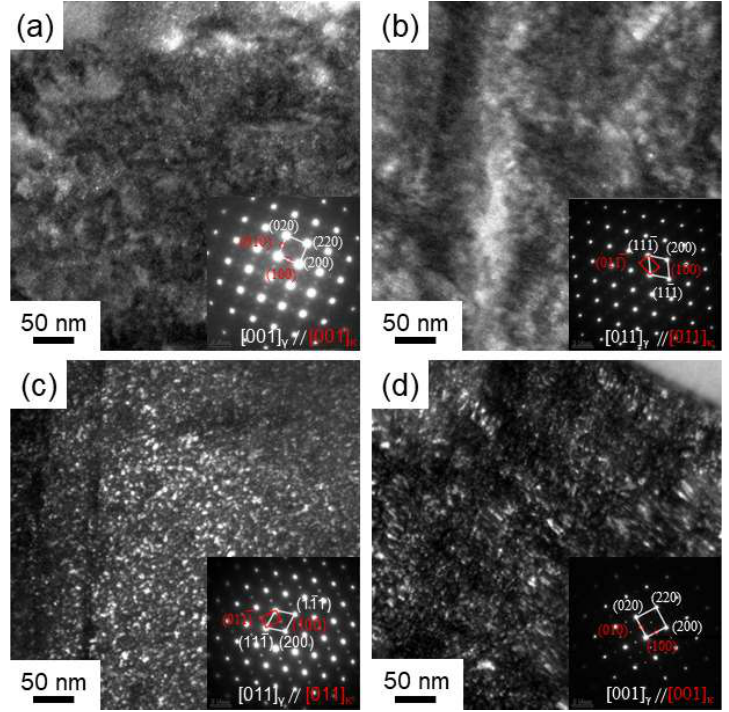
Figure 5. TEM weak beam dark field (WBDF) images of ( a ) S1000, ( b ) A450, ( c ) A500 and ( d ) A550 specimens.